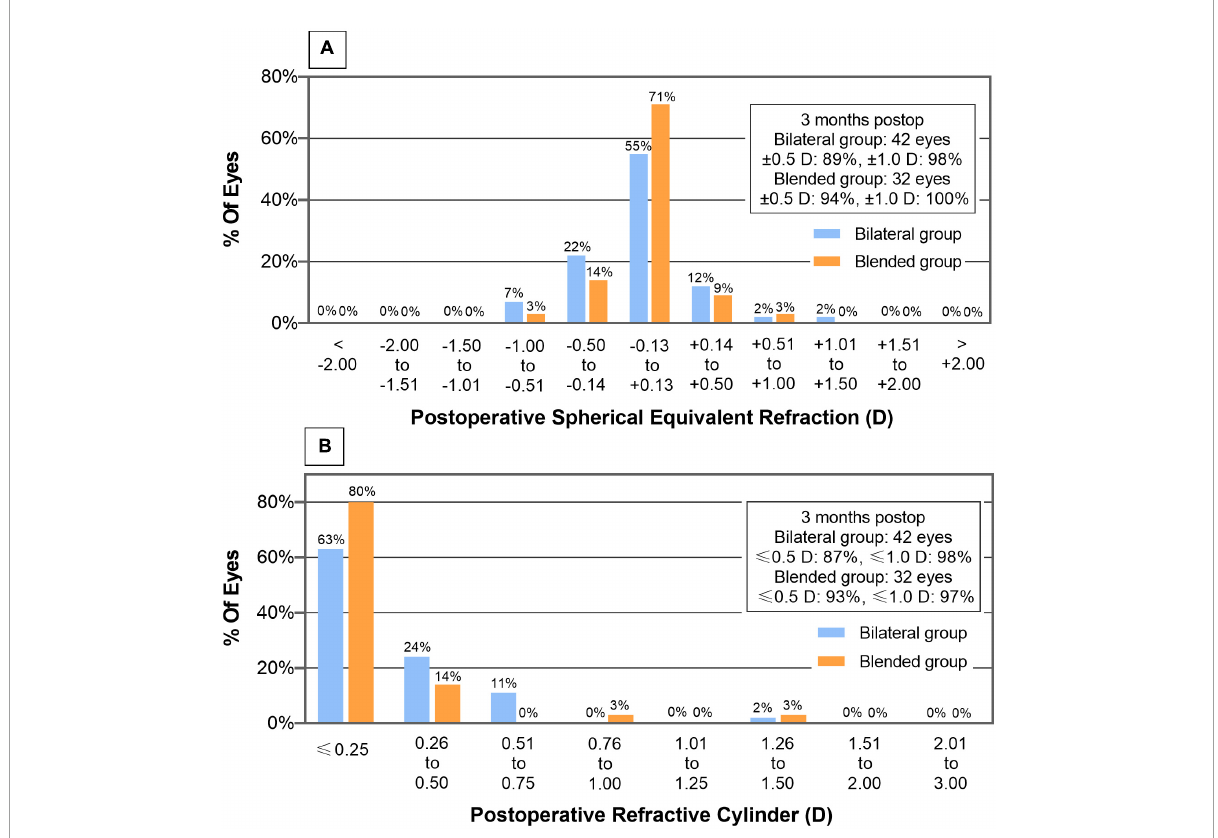
FIGURE4 Distribution of postoperative spherical equivalent (A) and refractive cylinder (B) of bilateral and blended groups.